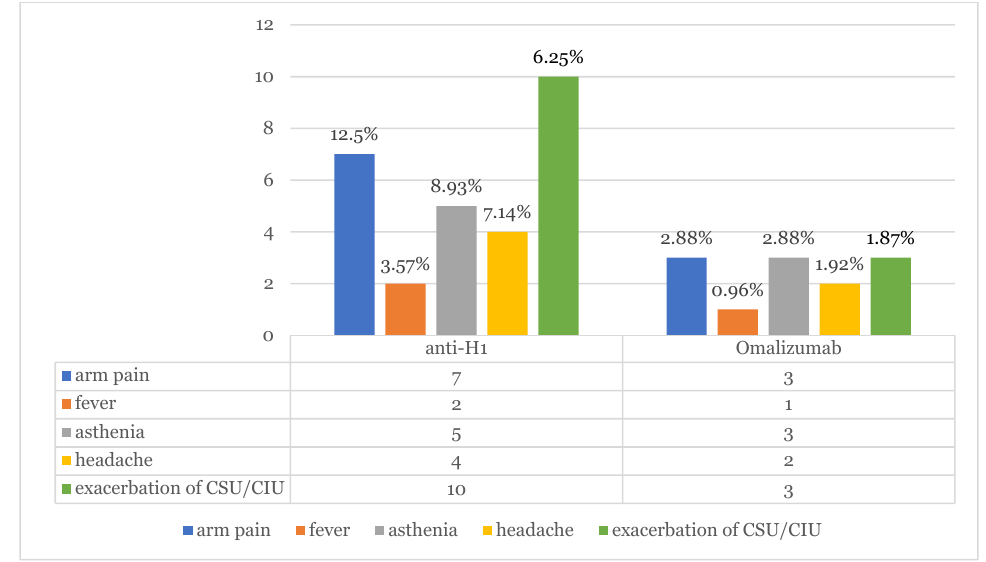
Figure 1. Adverse Events Following Immunization (AEFI) and exacerbation of CSU/CIU symptoms observed in patients taking antihistamines and omalizumab therapy, respectively.